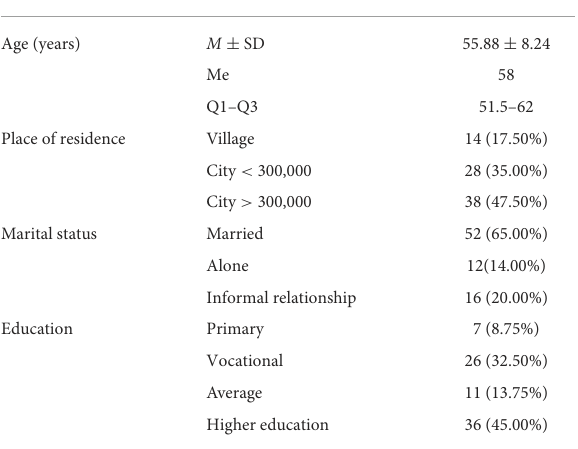
TABLE 1 Sociodemographic characteristics of the study group ( N =